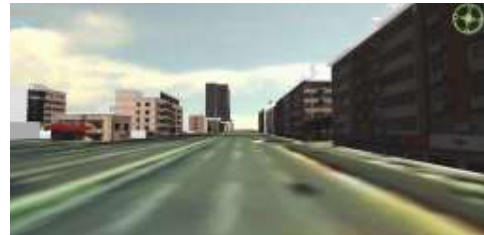
Figrue 4. Buildings with texture from panoramic images